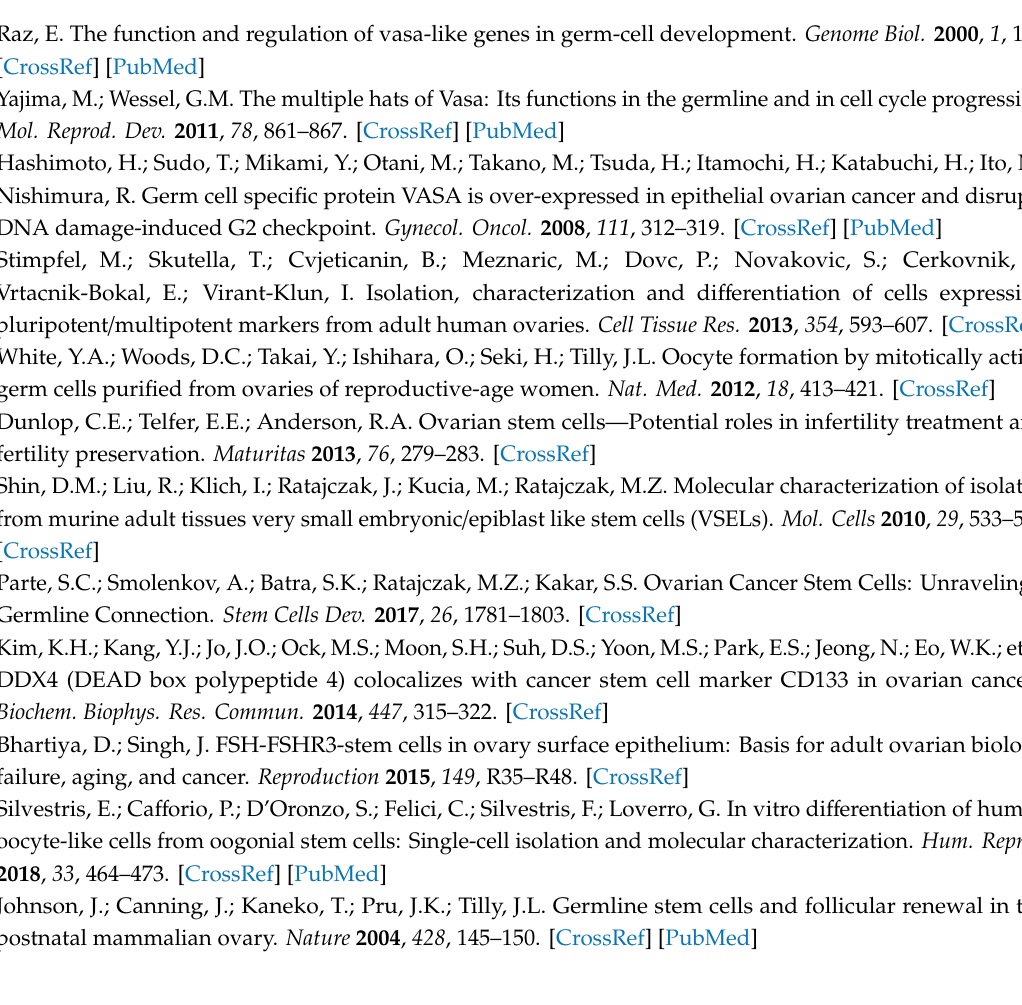
Table S1: Clinical details of OC patients. Table S2: GO enrichment analysis of di ff erentially expressed genes in A2780 cells co-cultured with Ddx4 + cells from both patients’